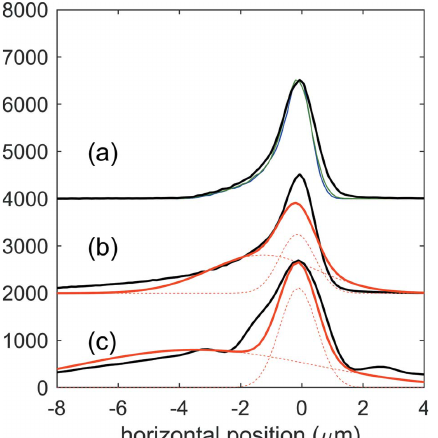
Figure 4 Curves ( a ), ( b ) and ( c ) in black are the projection in the vertical direction of the focal beam profiles shown in Figs. 3( a ), 3( b ) and 3( c ), respectively. The projection of the profile obtained from a simulation assuming a source without extension in the longitudinal direction [( a ), black] is compared with the projection of the same profile, assuming no diffraction effects from the finite length of the mirrors [( a ), green], and assuming no surface error and no diffraction effects [( a ), blue]. The projection of the profiles obtained from a simulation assuming an extended source over the last ten undulator cells [( b ), black] and the projection of the profile measured by the wavefront sensor [( c ), black] are compared with the projection of a fitting distribution made of the sum of two 2D Gaussian profiles [( b ) and ( c ), red]. The projections of the individual Gaussian contributions are also plotted as dashed red